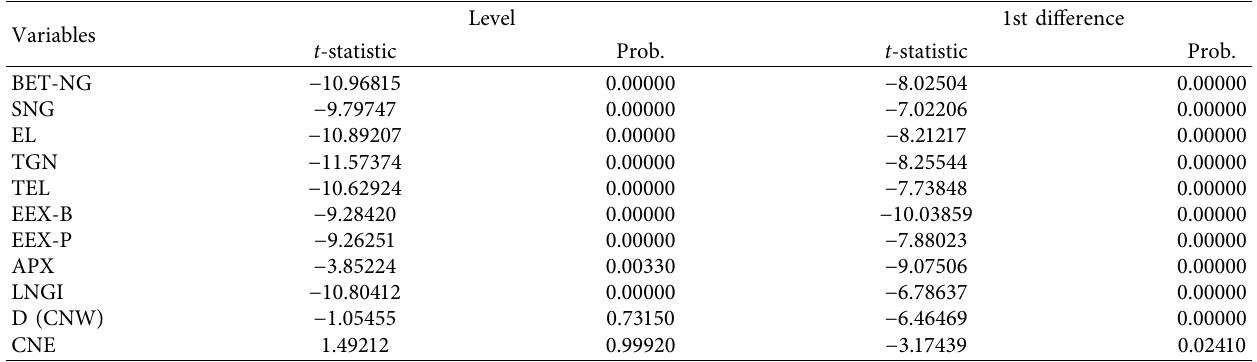
Table 4: The outcomes of the augmented Dickey–Fuller unit root test.